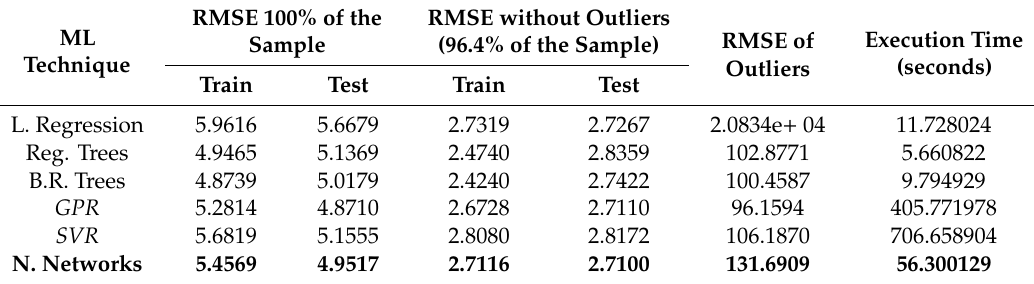
Table 7. BMI-CTDI VOL results for women’s Thorax, Abdomen & Pelvis